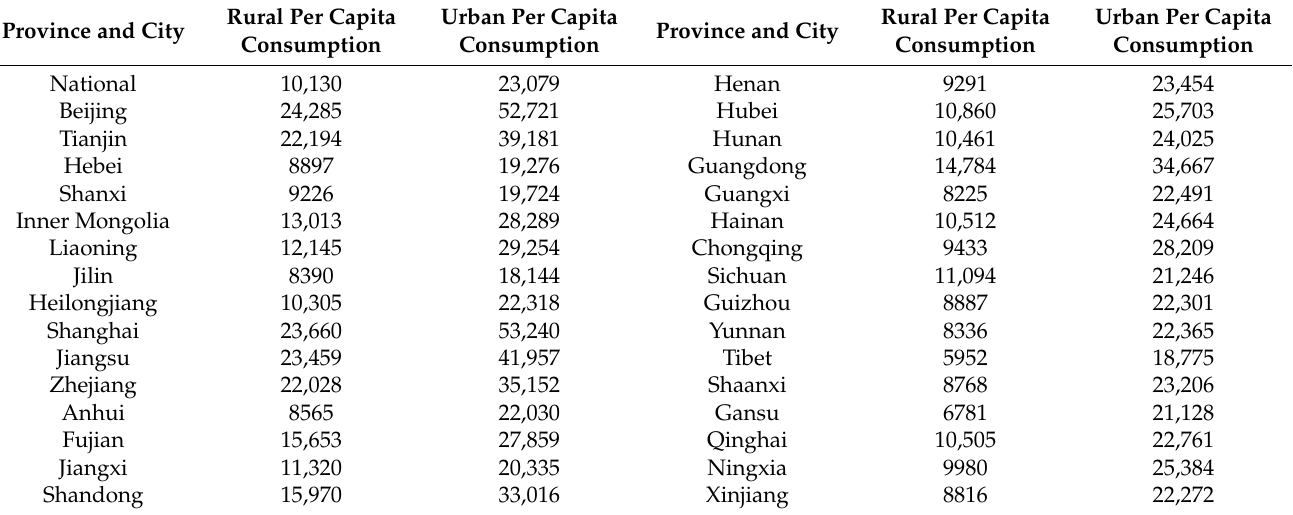
Table 2. Per capita consumption expenditure of urban and rural residents in provinces and cities of China in 2016